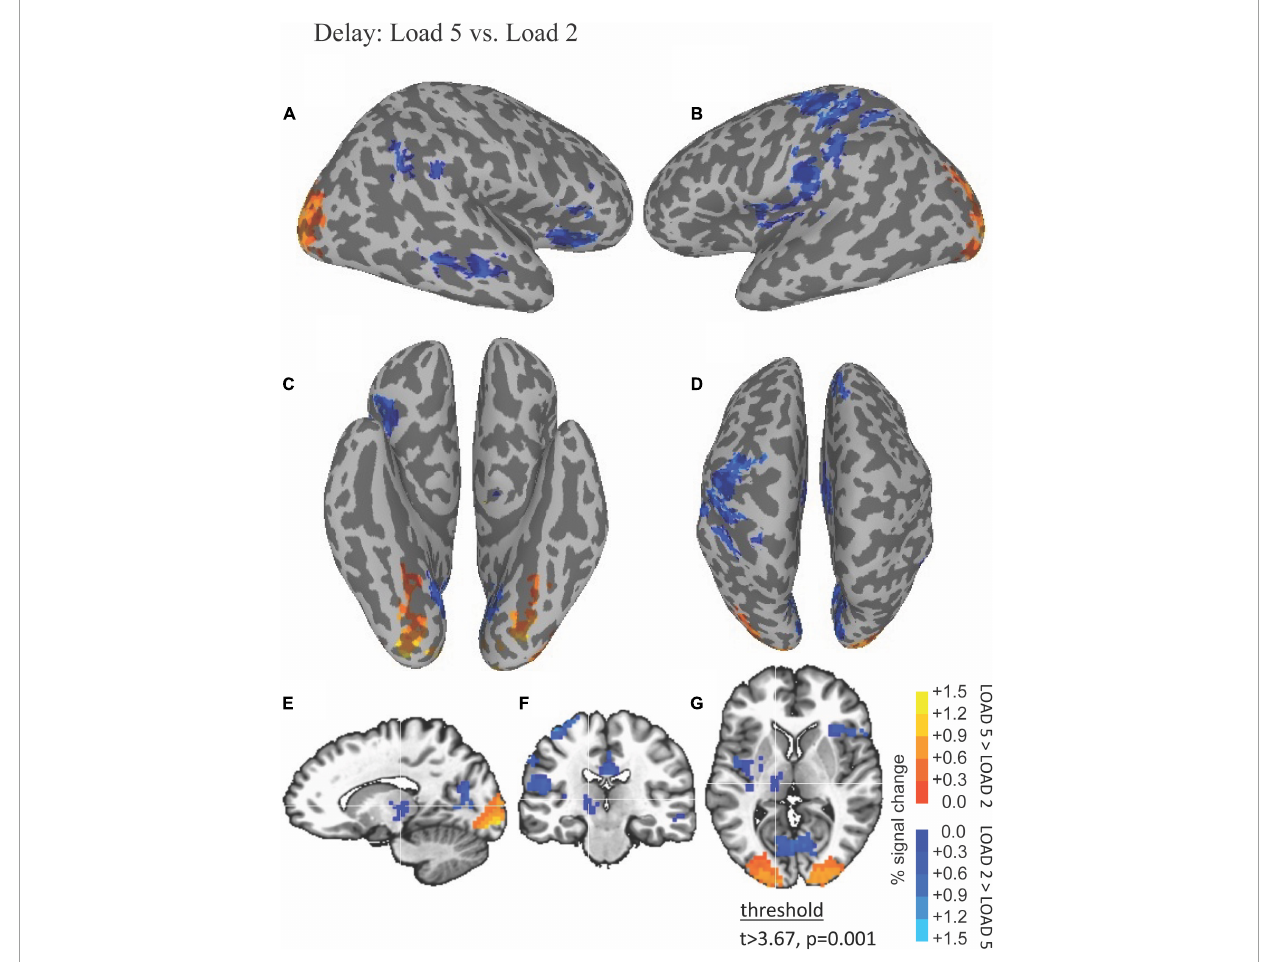
FIGURE4 Functional magnetic resonance imaging (fMRI) differences between high and low load during the delay period. Thresholded fMRI statistical maps ( t > 3.67, p = 0.001, and cluster size > 40 voxels) displayed on inflated cortical surface representations [ (A) left hemisphere, (B) right hemisphere, (C) ventral view, and (D) dorsal view] and orthogonal views [ (E) sagittal, (F) coronal, and (G) axial view]. The crosshairs in the orthogonal view is located x = –10, y = –17, and z = 12 mm, the peak location of a cluster of activity in medial dorsal nucleus of the thalamus that was greater for low compared to high load during the delay